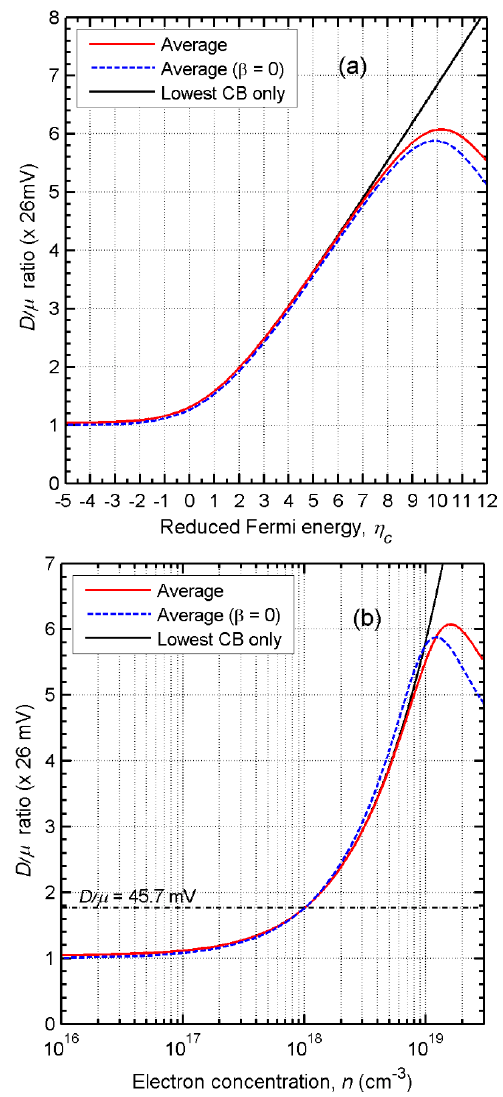
Figure 8. Calculated values of the D / μ ratios for conduction electrons as a function of the reduced FE in ( a ); as well as a function of the electron concentration in ( b ), in the three different cases for GaAs ( T L = 300 K).